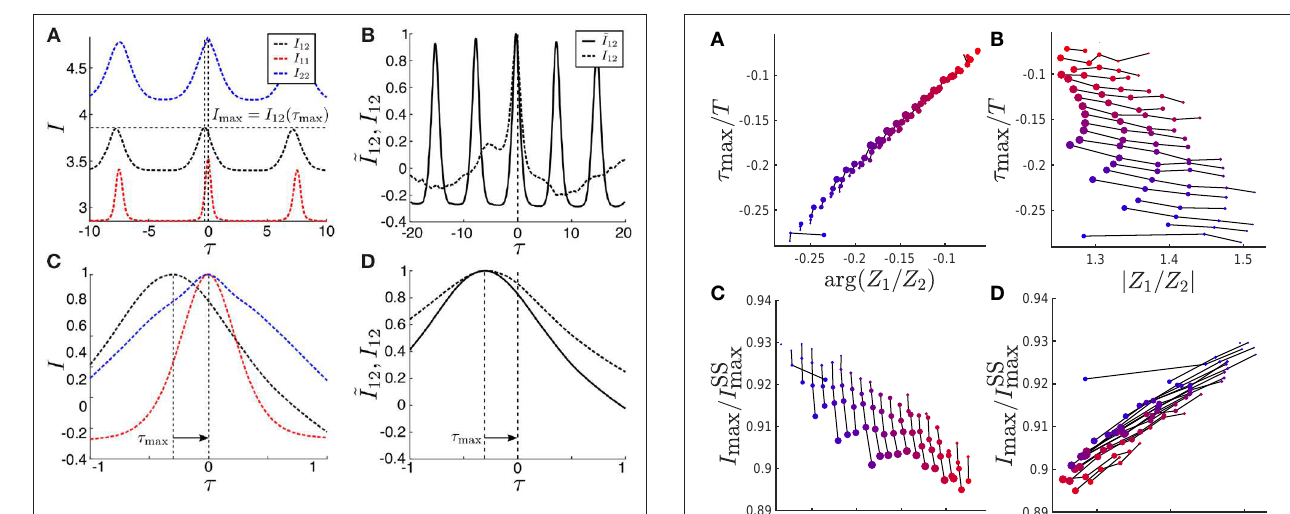
FIGURE 2 | (A) Mutual informations I µν as a function of τ between and within the two subpopulations µ and ν . (C) The range-zoomed curve reveals a directionality in the mutual information I 12 ( τ ) between the two subpopulations 1 and 2, with a maximum peak I max : = I 12 ( τ max ) located at τ max < 0. (B,D) Comparison of the average mutual information obtained from continuous time data (solid), ˜ I 12 , vs. event time data (dotted), I 12 . Obviously, locations of the peaks agree very well. (B–D) display the average mutual information ( I − h I i t ) / max t ( I − h I i t ) with h I i t denoting the average over time after discarding a transient (see text for details). Parameters across panels are A = 0.275, β = 0.125, σ ω = 0.01, σ C = 0.01, σ 2 W = 0.001.